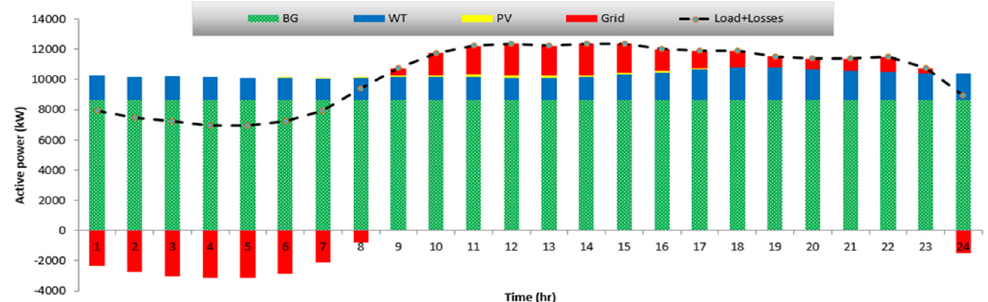
Figure 18. Results of the second MG operation without optimal control.